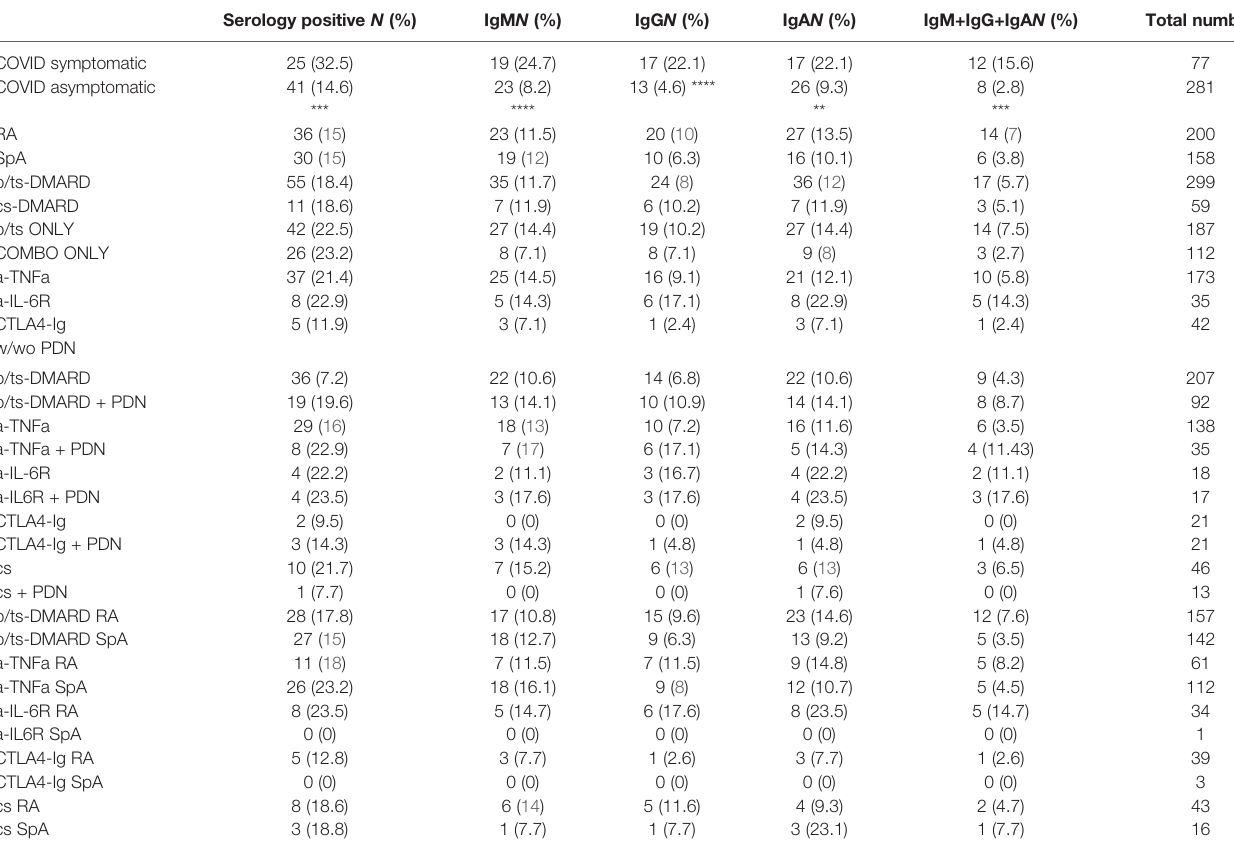
TABLE 1 | Anti-RBD seroprevalence of RMD patients and associated clinical features. Serology positive N